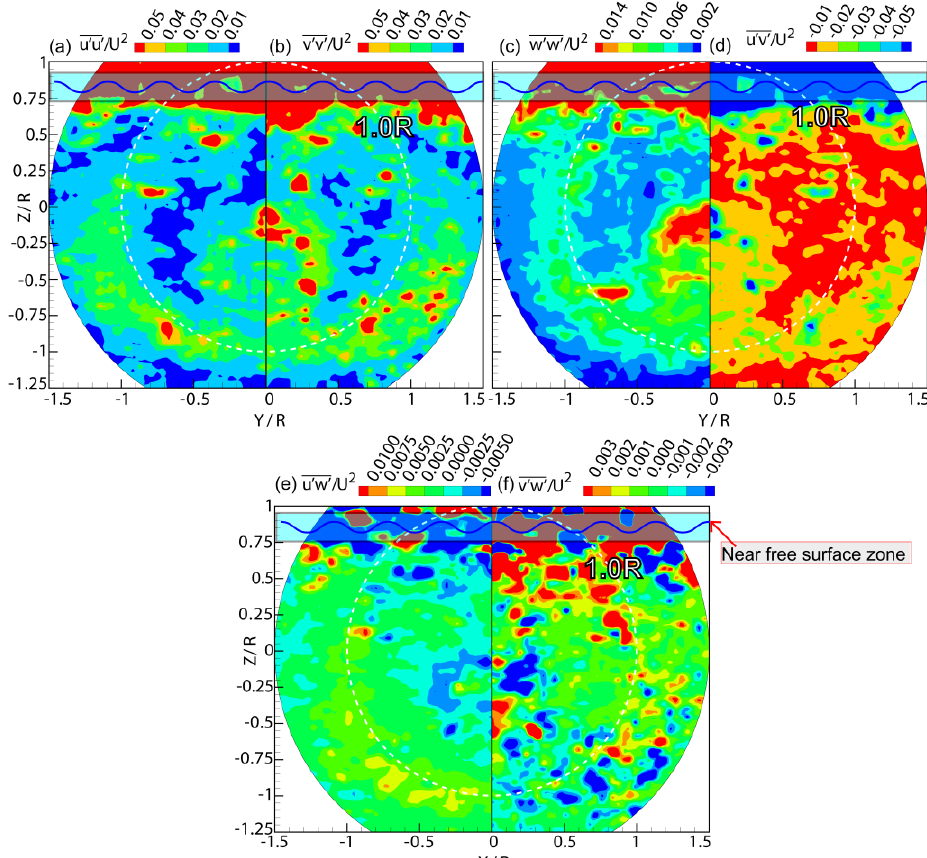
Figure 8. The turbulent kinetic energy (TKE) in the propeller region: Left . The ballast conditions; Right . The design condition.